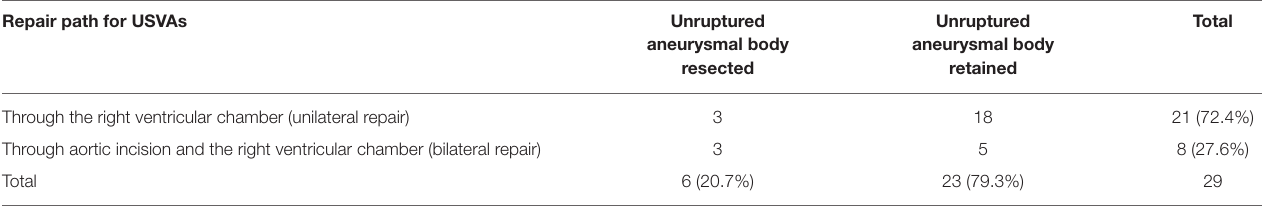
Unruptured Total aneurysmal body aneurysmal body resected retained